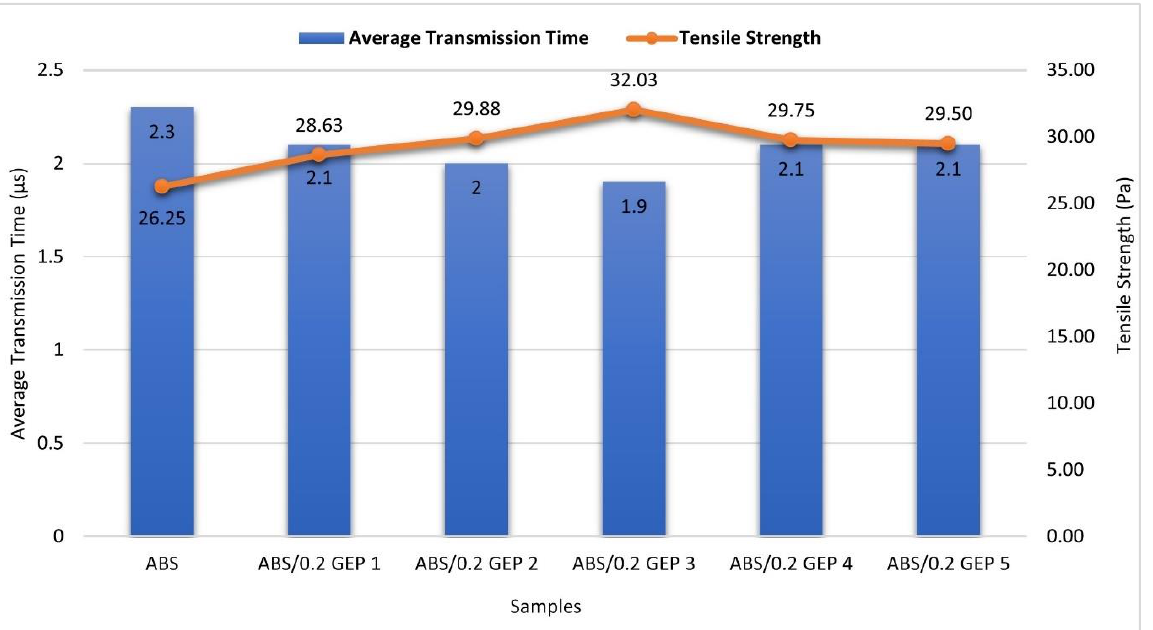
Figure 13. Comparative tensile test results for ABS/0.2 GEP composites: ( a ) results from tensile testing with standard deviation as error bars; ( b ) stress-strain curve.